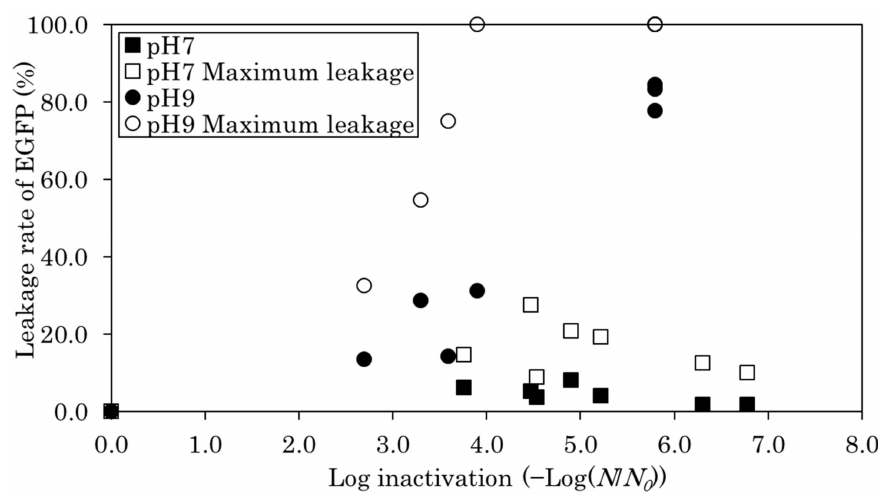
Figure 3. E. coli log inactivation and leakage rate of enhanced green fluorescent protein (EGFP) during chlorine treatment at pH 7 and 9. The leakage rate of EGFP that was calculated using measured values is plotted as a function of E. coli log inactivation. To consider the decrease in the fluorescence intensity of leaked EGFP, the maximum leakage rate was calculated from the CT value based on the results of Figure 1 and plotted.